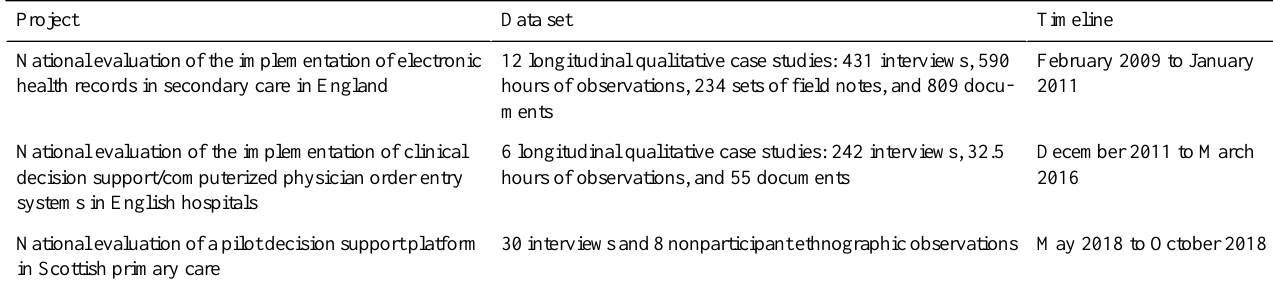
Table 2. Data set informing the development of the evaluation